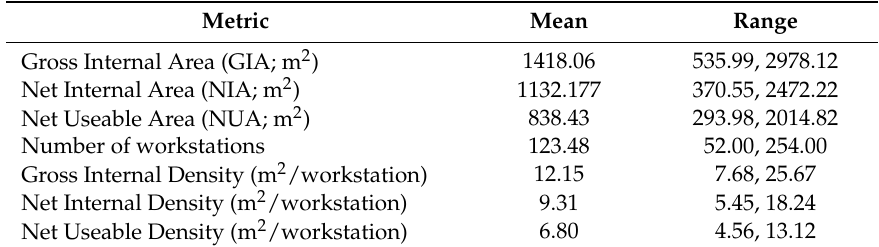
Table 1. Spatial characteristics of organisations in the Active Buildings study.